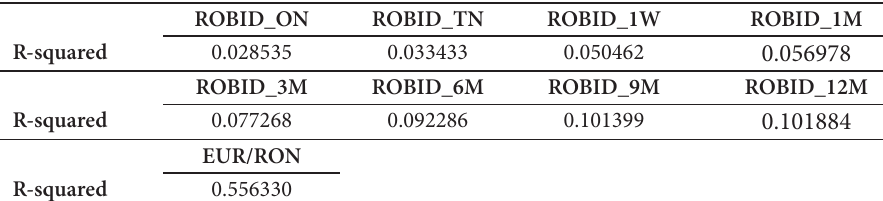
Table 1. R-squared results for simple regressions of BET index against ROBID and EUR/RON ROBID_ON ROBID_TN ROBID_1W ROBID_1M R­squared 0.028535 0.033433 0.050462 0.056978 ROBID_3M ROBID_6M ROBID_9M ROBID_12M R­squared 0.077268 0.092286 0.101399 0.101884 EUR/RON R­squared